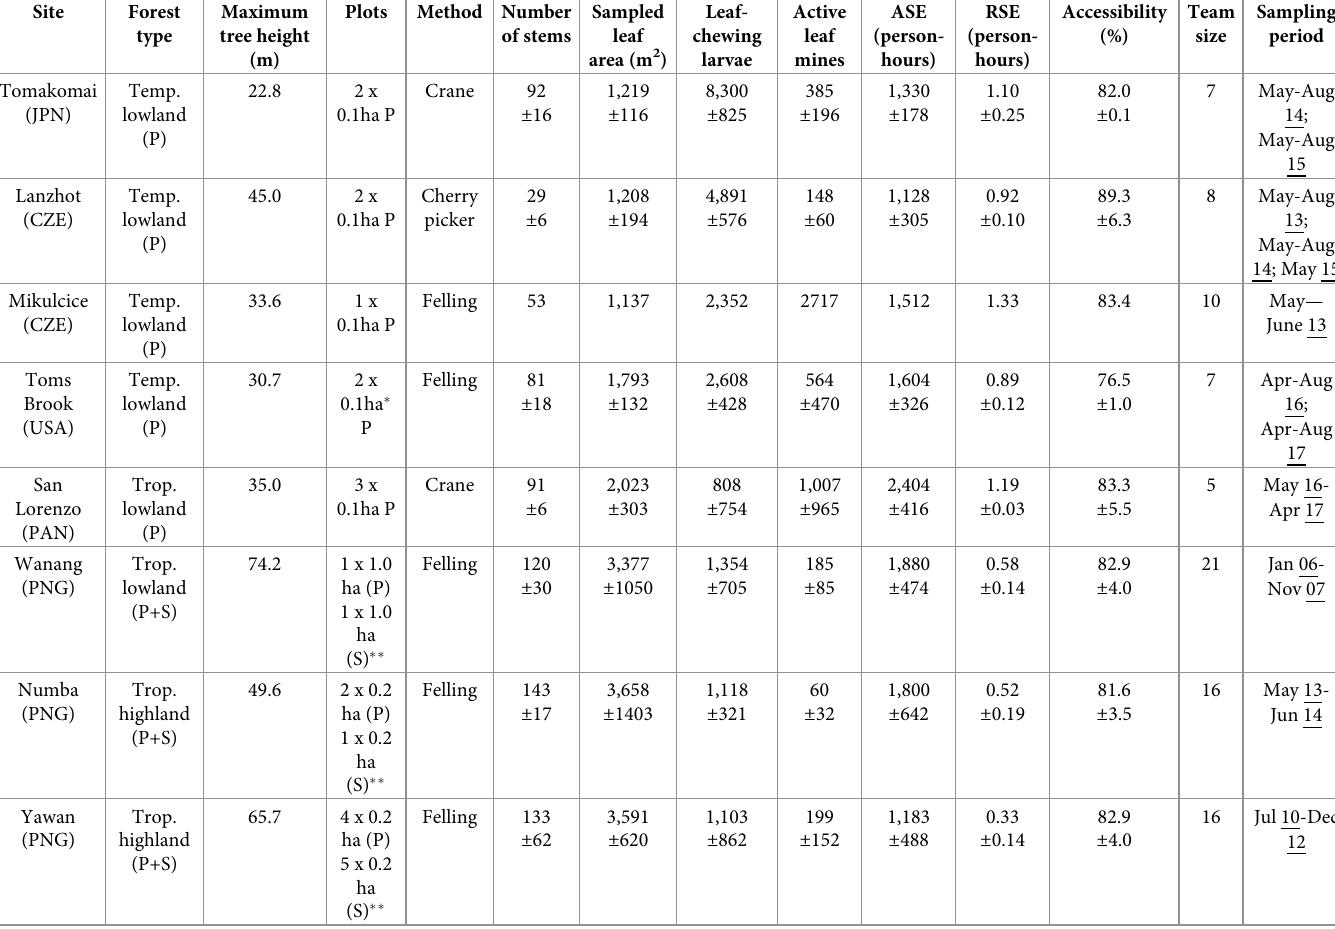
Table 2. Sampling site characteristics. Forest type (Trop—tropical., Temp—temperate), lowland (90–230 m a.s.l.), highland (700–1800 m a.s.l.), primary (P), and sec- ondary (S) forests); Maximum tree height (m); Plots (number and size of sampled plots); Method of sampling; mean Number of stems with DBH � 5 cm per 0.1 ha ( ± SD); mean Sampled leaf area (m 2 ) per 0.1 ha ( ± SD); mean number of Leaf-chewing larvae per 0.1 ha ( ± SD); mean number of Active mines per 0.1 ha ( ± SD); mean Area-based sampling effort per 0.1 ha (ASE, person-hours; ± SD); mean Resource-based sampling effort (RSE, person-hours per 1 m 2 of foliage; ± SD); mean Accessibility (% of foliage accessed; ± SD); average Team size in the field and lab combined; and Sampling period (month and year). See S2 Table for data by individual plots and all arthropod groups.